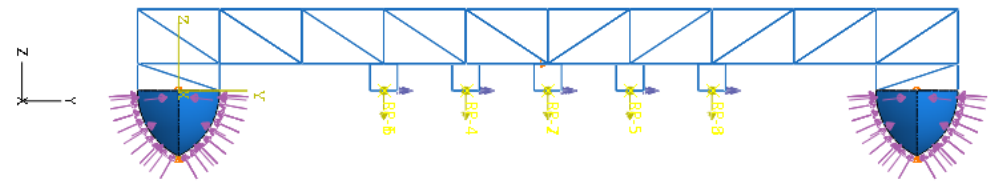
Figure 6. Loads applied to the model for finite element analysis (FEA).